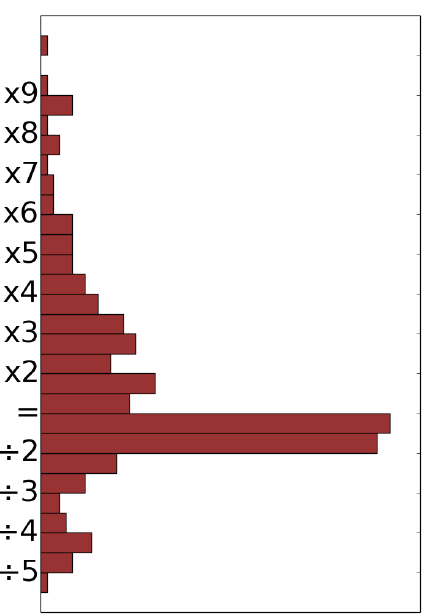
Figure 4. Distribution of the scaling factors applied to the emission databases in order to compute the “truth”. All the emission compo- nents of the state vector have been included in the histogram. The selection of the scaling factor distribution is detailed in Sect. 5.1.